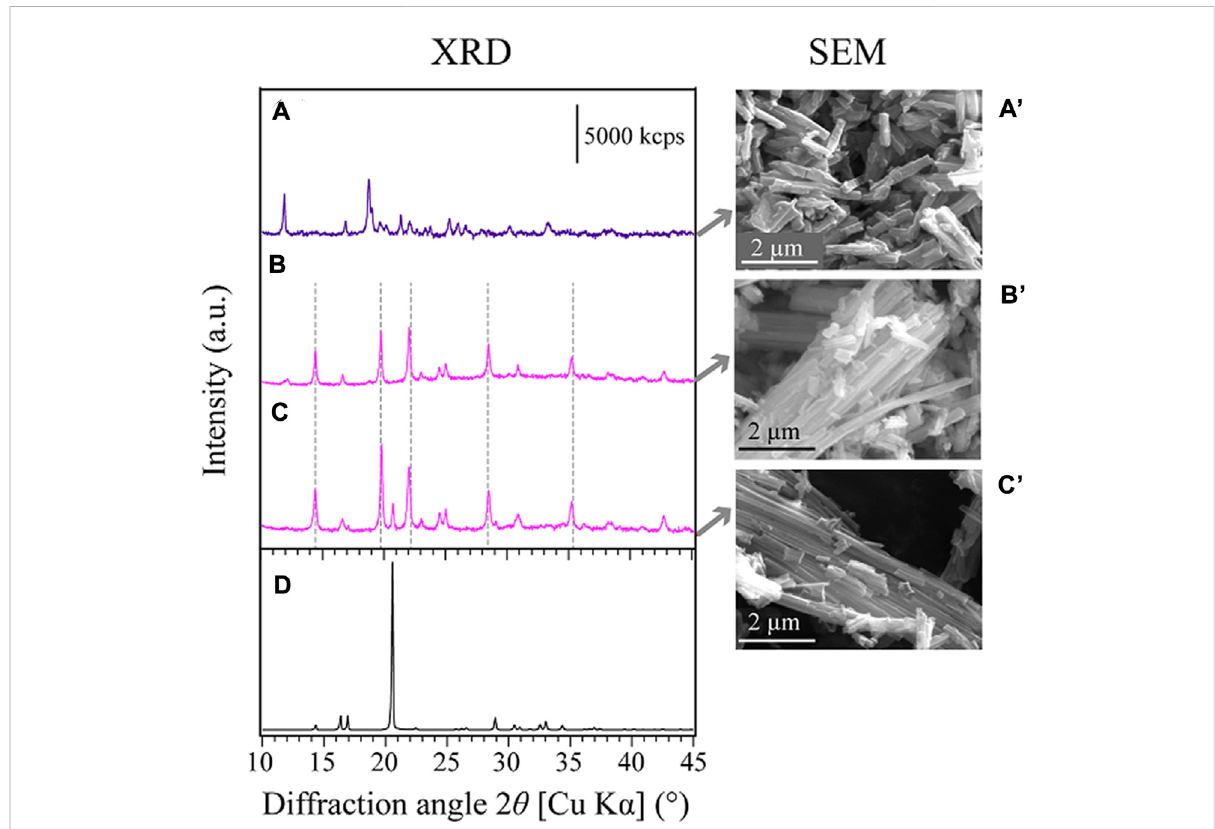
FIGURE 5 ComparisonofXRDpatterns (A – D) andSEMimages (A 9 – C 9 ) ofsynthesizedCo-Alaprecipitates: (A,A 9 ) Co-Alacomplexproducedbytheethanol re fl ux method at 80 ° C. (B,B 9 ) Co-Ala complex produced from pure Ala and Co 2+ reagents at 45 ° C. (C,C 9 ) Co-Ala complex formed in the actual spent catalyst leachate (spent catalyst particles separated prior to Co-Ala precipitation) at 45 ° C. (D) Pure Ala reagent. (A – C) All XRD peaksderived from the synthesized Co-Ala complexes under each condition and did not match the